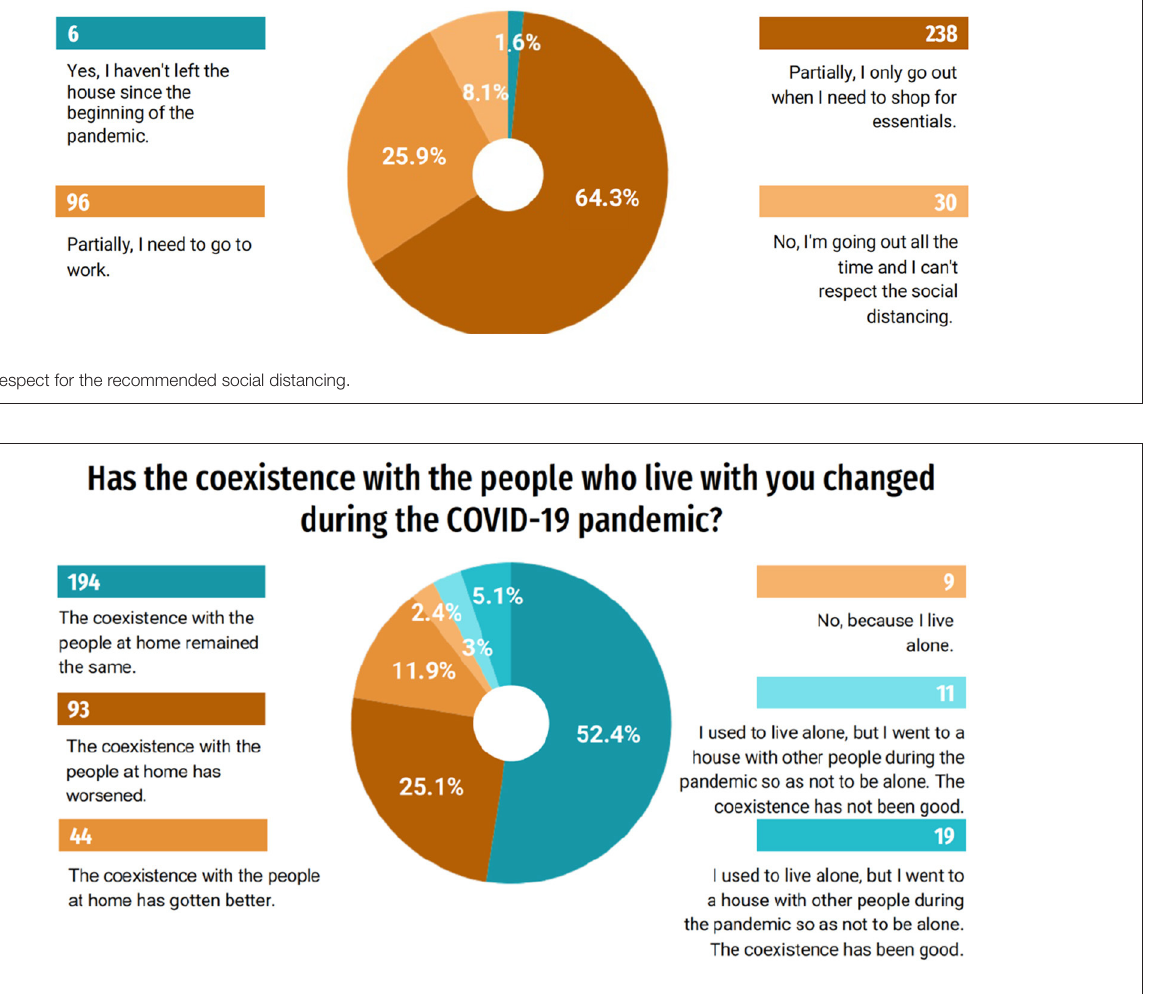
FIGURE 2 | Coexistence with the people who live with the student during the